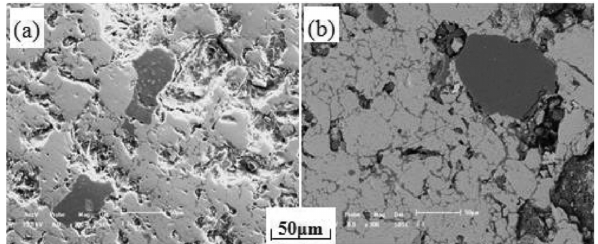
Figure 7: Photos of SEM and EDS of pellets after roasting at 1,523K (a) bentonite content 1.0%; (b) bentonite content 0.2% + combination additive content